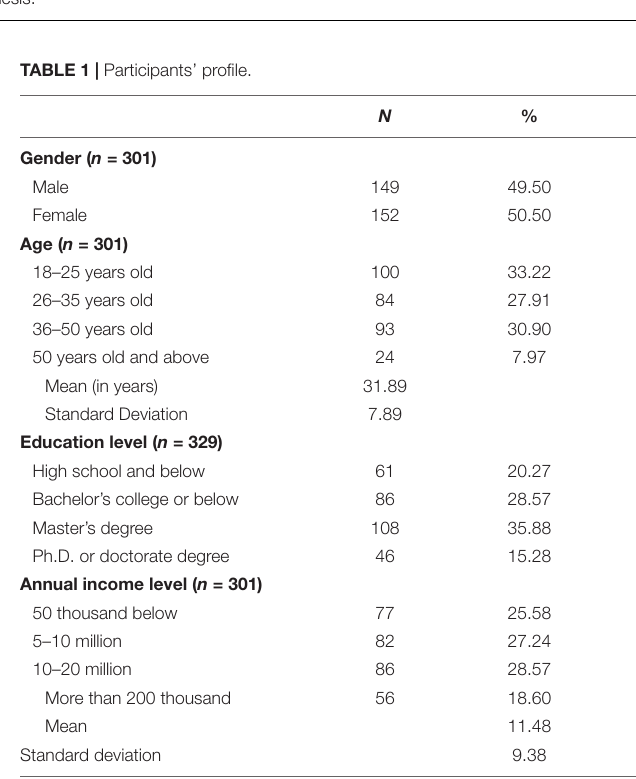
FIGURE 2 | The proposed conceptual stage model of service recovery. H, hypothesis.